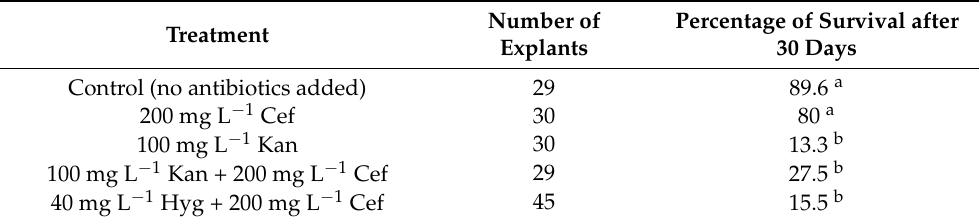
Table 2. Summary of the antibiotic combined tests conducted with different concentrations. a Significant difference at the 1% level between a and b populations. b No significant difference within a nor b populations (proportion test). Number of Percentage of Survival after Treatment Explants 30